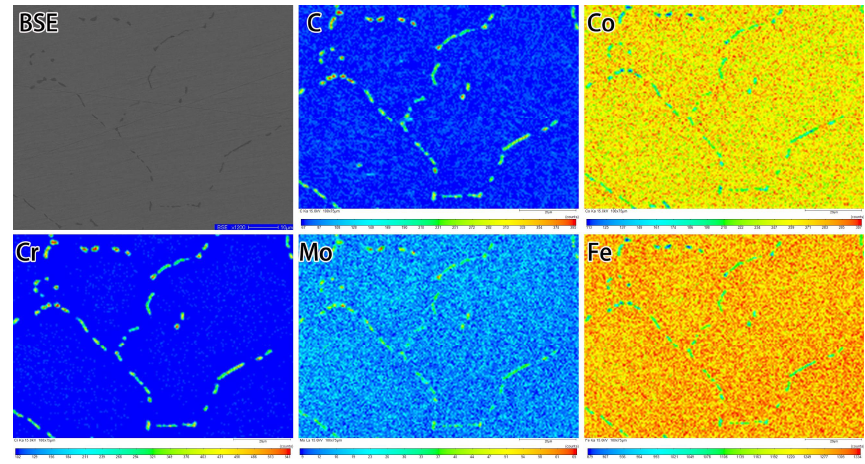
Figure 6. EMPA at 0.1 mm on the surface of process L2.